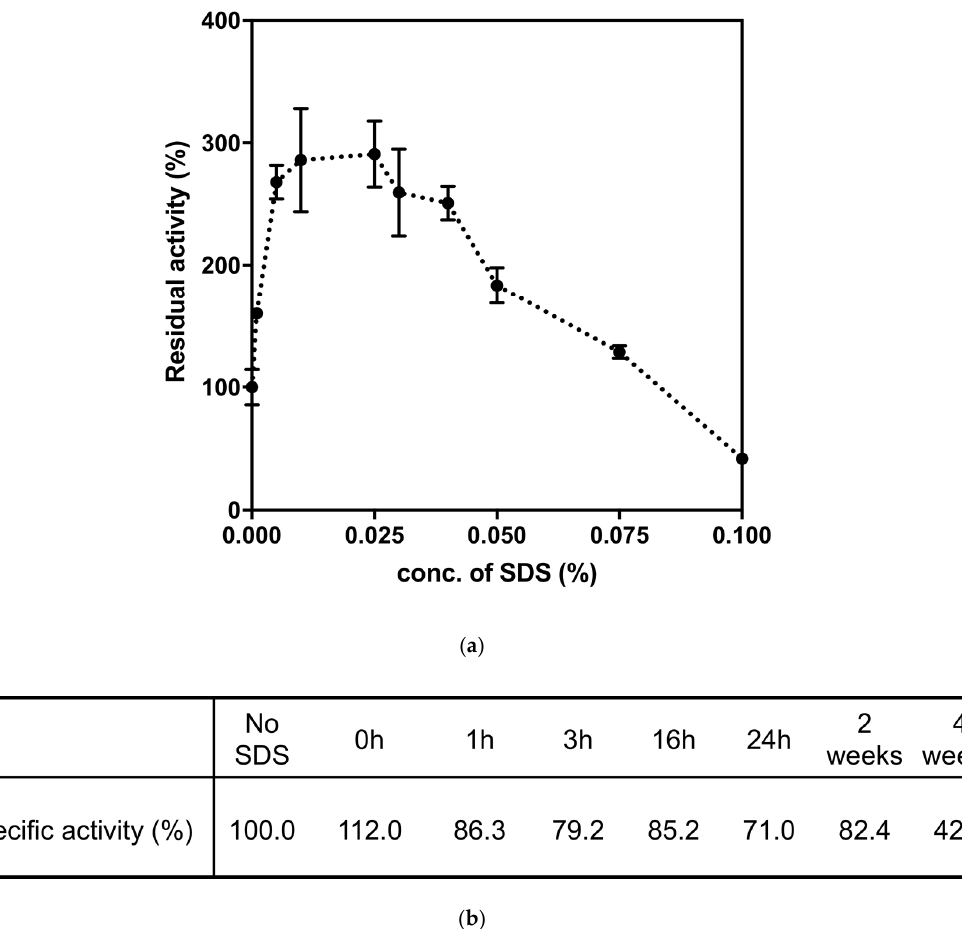
Figure 4. ( a ) Effect of SDS on paraoxonase activity of 4Mut. Standard assay was performed under the presence of different concentration of SDS as indicated. ( b ) Stability of 4Mut on SDS. 4Mut was incubated in buffer (20 mM HEPES-NaOH pH 8.5, 0.5 mM CoCl 2 , 200 mM NaCl) with 0.025% SDS at room temperature. Samples were withdrawn at indicated times and analyzed by standard assay at 70 °C .